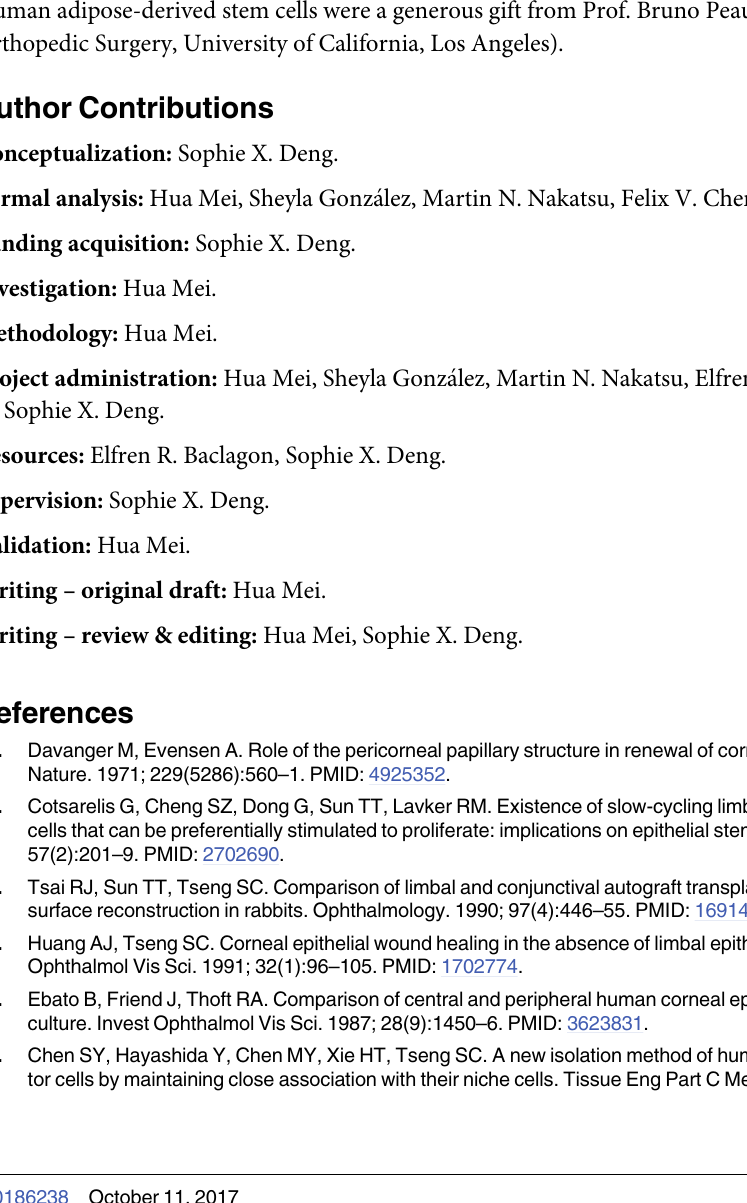
S1 Fig. Representative images showing the cell clusters of LECs. The cell clusters of LECs were obtained by Dispase digestion of corneoscleral rim followed by mechanical scraping and pippeting. The cell clusters of LECs were composed of mainly single cells and some small cell clusters (usually around 2 to 20 cells/cluster). The cell clusters in dashed rectangles are enlarged at the sides of the images. Scale bar = 100 μm. S1 Table. Primers used in qRT-PCR. S2 Table. Primary antibodies used in